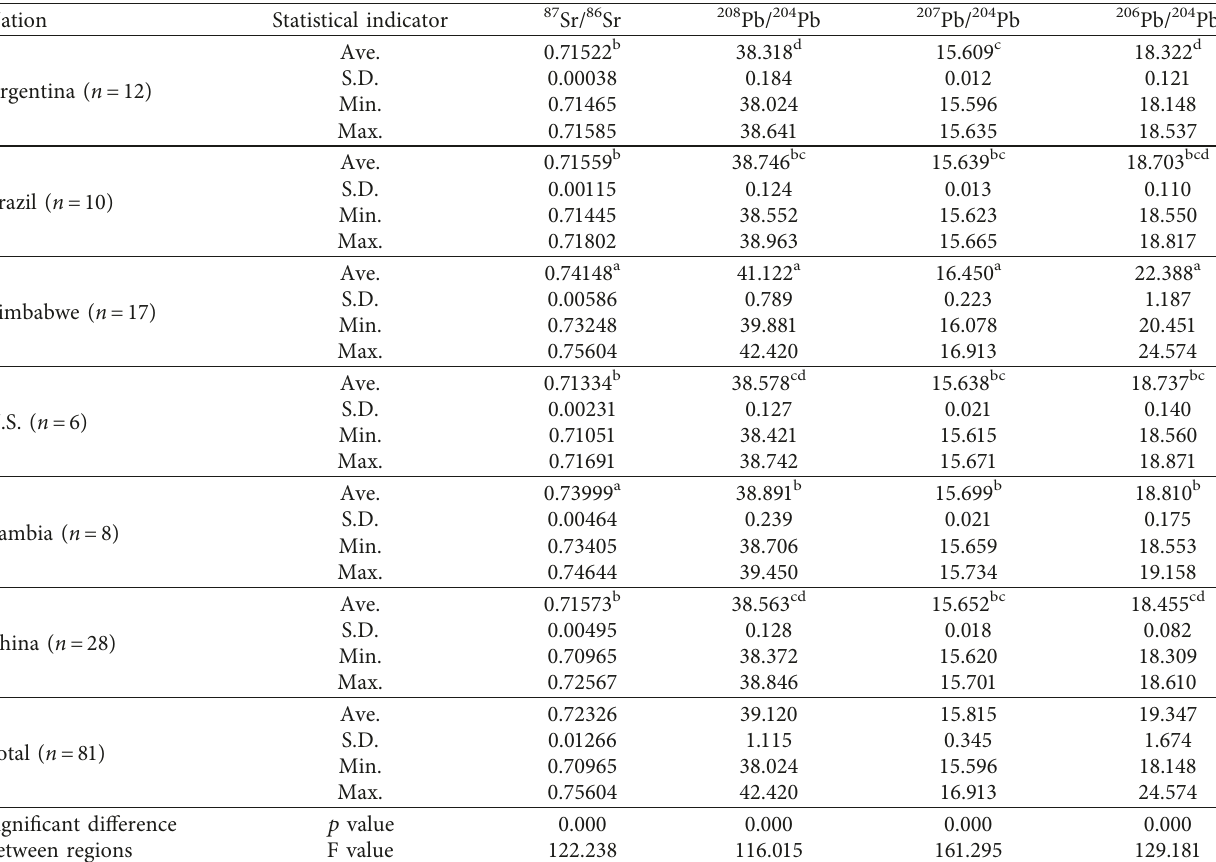
Table 2: The Strontium and lead isotope ratio in the tobacco leaf from different countries.